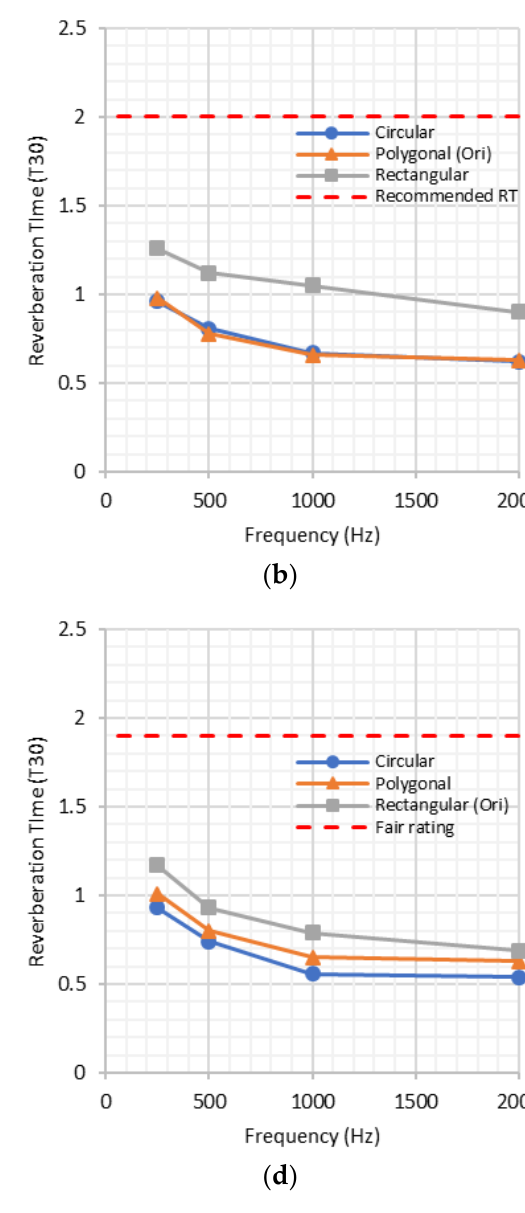
Figure 5. Comparison of the average RT among various chancel shapes: ( a ) C1; ( b ) P1; ( c ) P2; ( d ) R1.